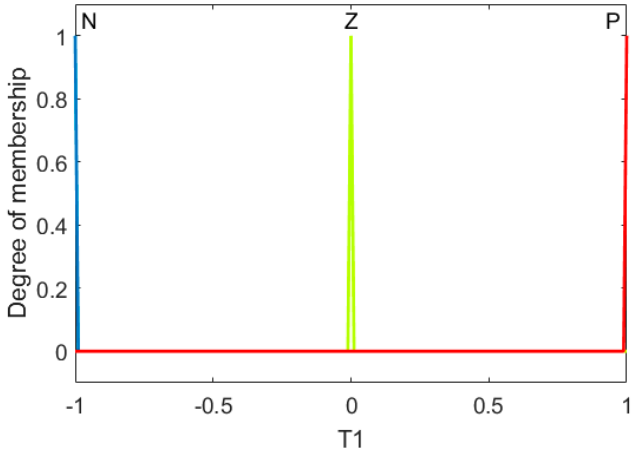
Figure 6. Input angular velocity (ew), not optimized.